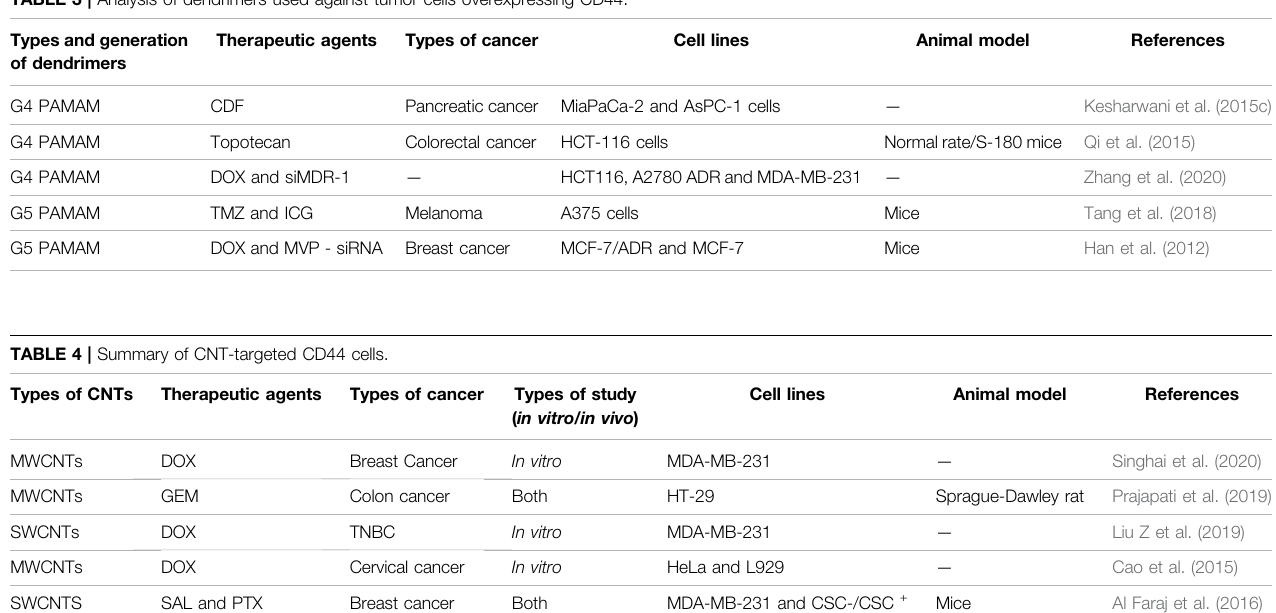
TABLE 3 | Analysis of dendrimers used against tumor cells overexpressing CD44.